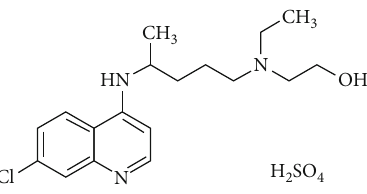
Figure 1: Chemical structure of hydroxychloroquine